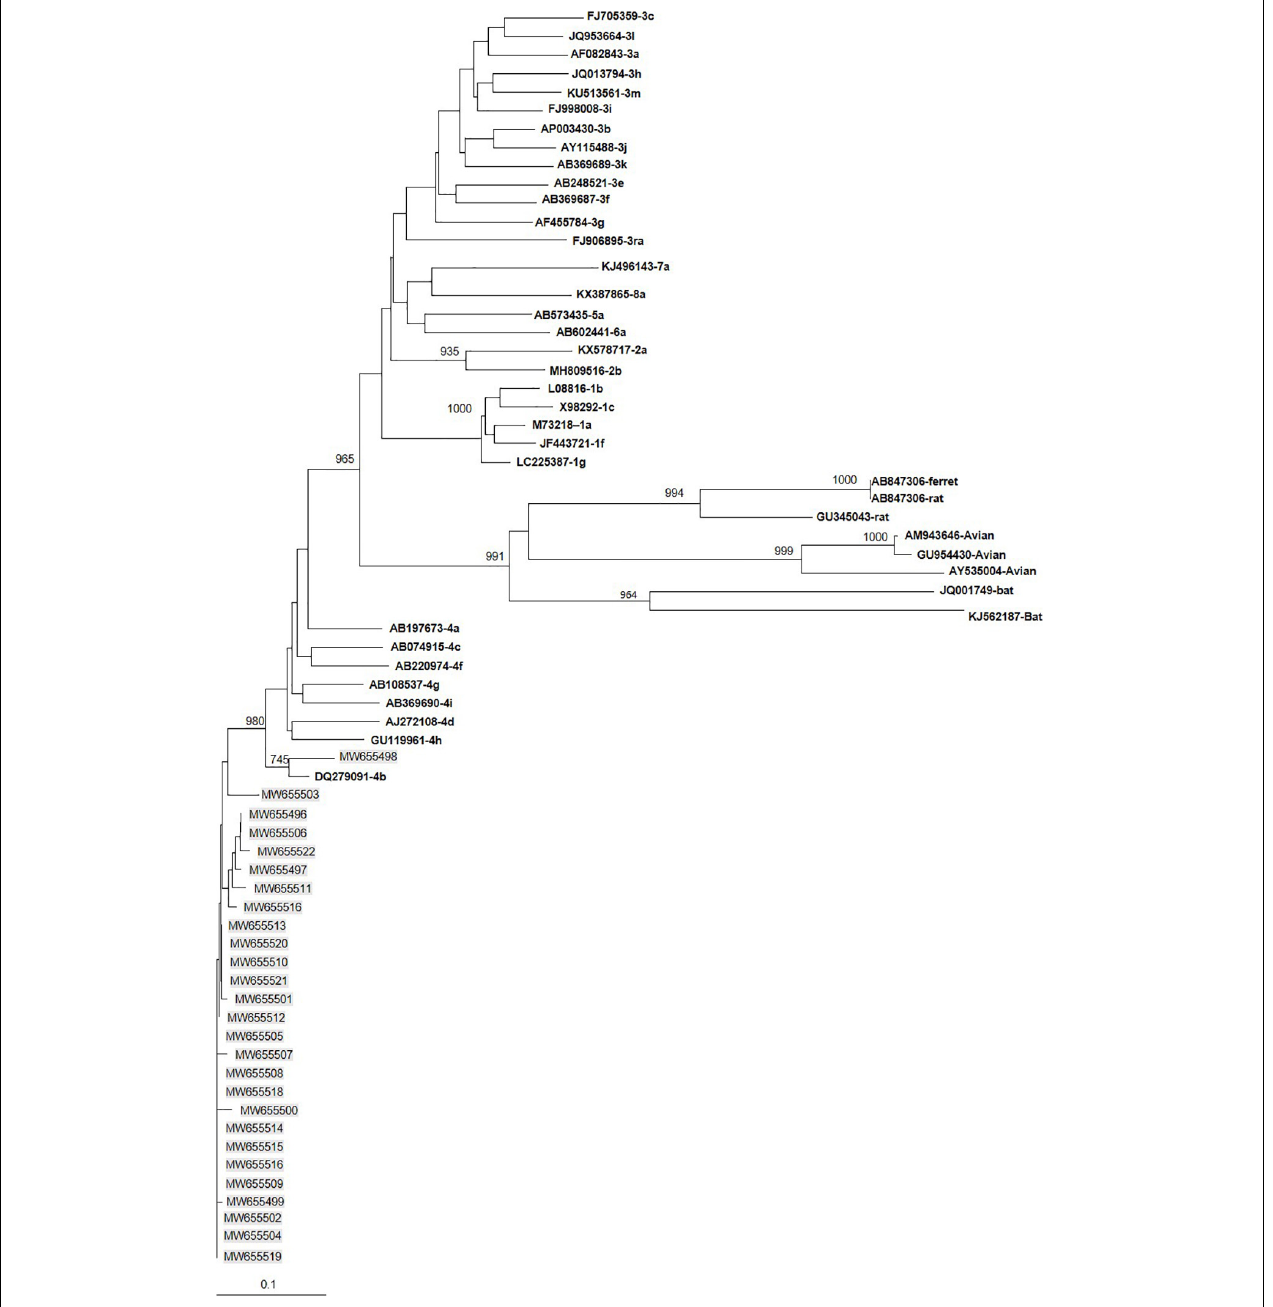
FIGURE 1 | Phylogenetic tree constructed using 345-nt-long partial sequences within ORF2. Genetic distances were calculated using the Kimura two-parameter method, phylogenetic trees were plotted by the neighbor-joining method. Bootstrap values acquired after 1,000 replications are shown (branch lengths measured in the number of substitutions per site). Patients’ sequences, with the accession number highlighted in gray, were compared to the reference sequences of subtypes 3 proposed by Smith et al. (2020). Accession numbers, genotype and subtypes of the reference sequences are in